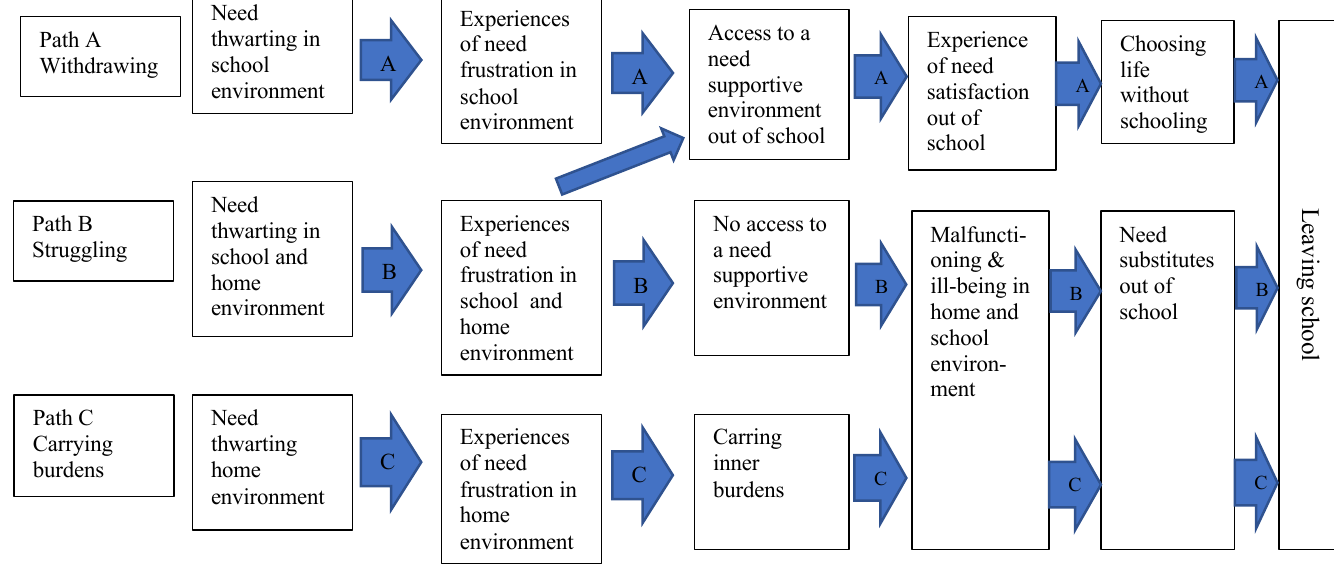
Figure1. A graphic overview of the paths identified in the narrative